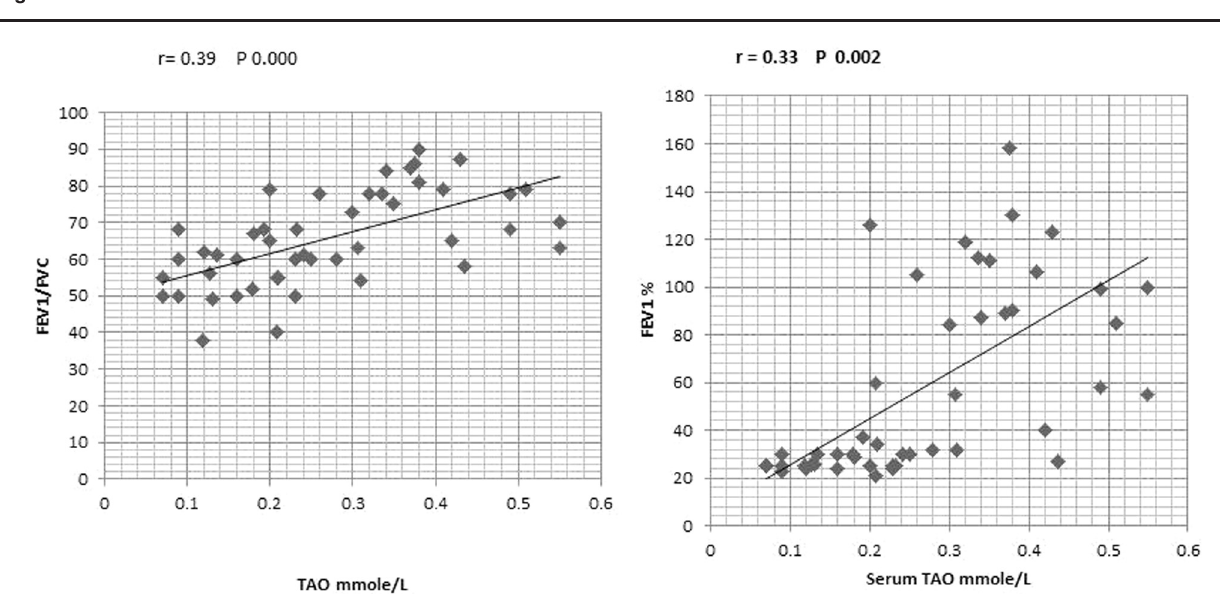
Correlations between serum total antioxidant (TAO) and pulmonary function